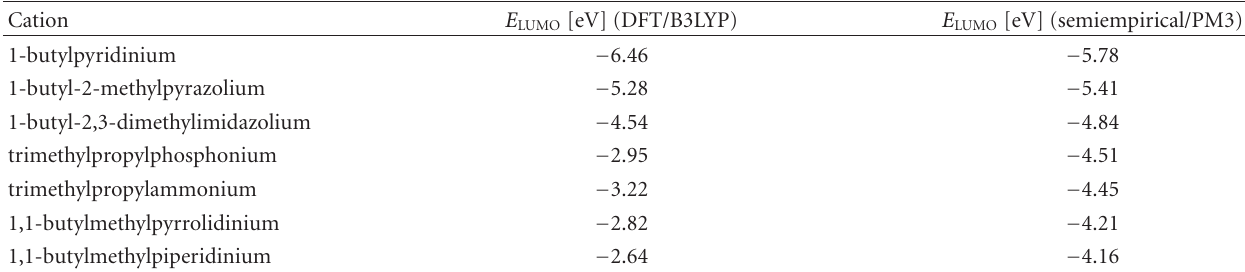
Table 4: Comparison of calculated E LUMO of several cations by B3LYP and PM3 calculations.